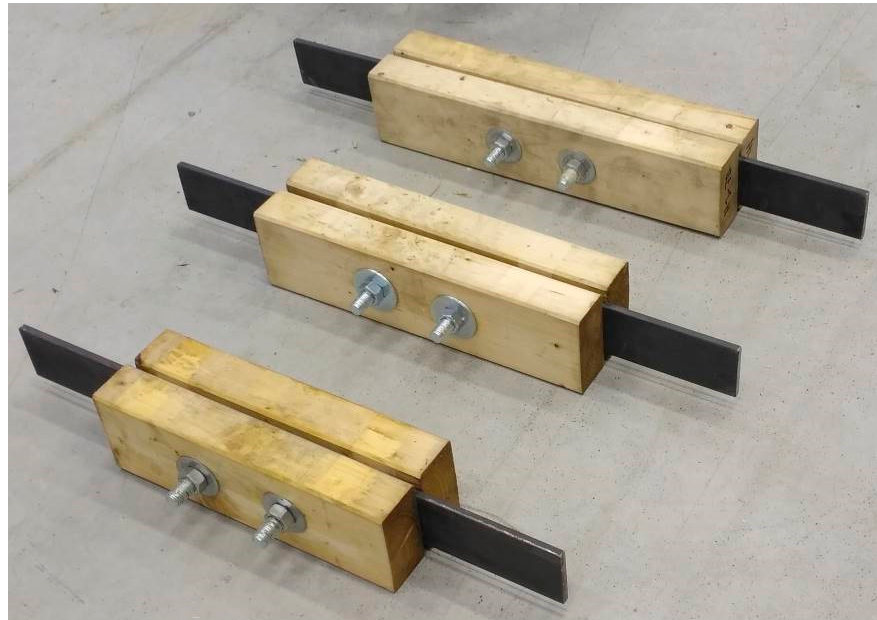
Figure 4. All types of squared specimens before testing.